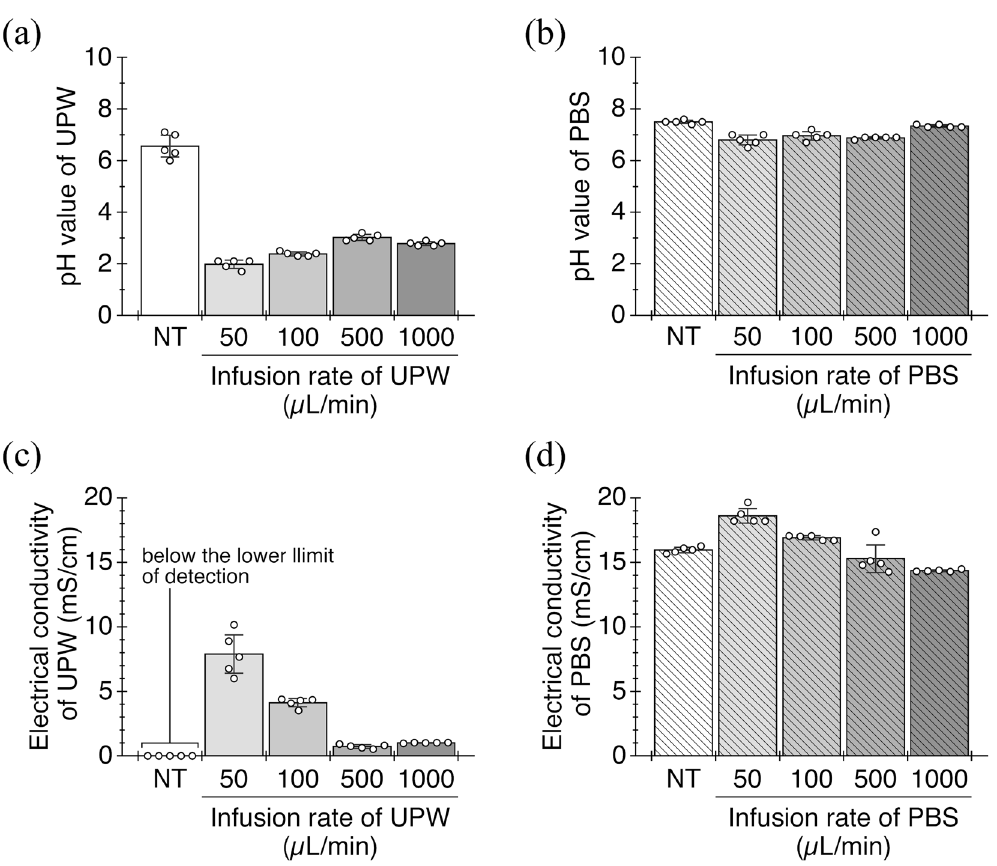
Figure 6. Physical characteristics of the nano-sized mist generated by the DBD. ( a, b ) The pH values of UPW and PBS before and after passing through the plasma discharge at each infusion rate (mean ± SD, n = 5). ( c, d ) Electrical conductivity of UPW and PBS before and after passing through the plasma discharge at each infusion rate (mean ± SD, n = 5). UPW, ultrapure water; PBS, phosphate buffered saline. NT, samples without plasma treatment (no